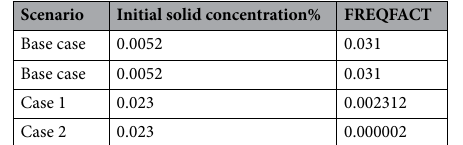
Table 2. List of test cases for the established study of the polymer model and cross-linked gel model.